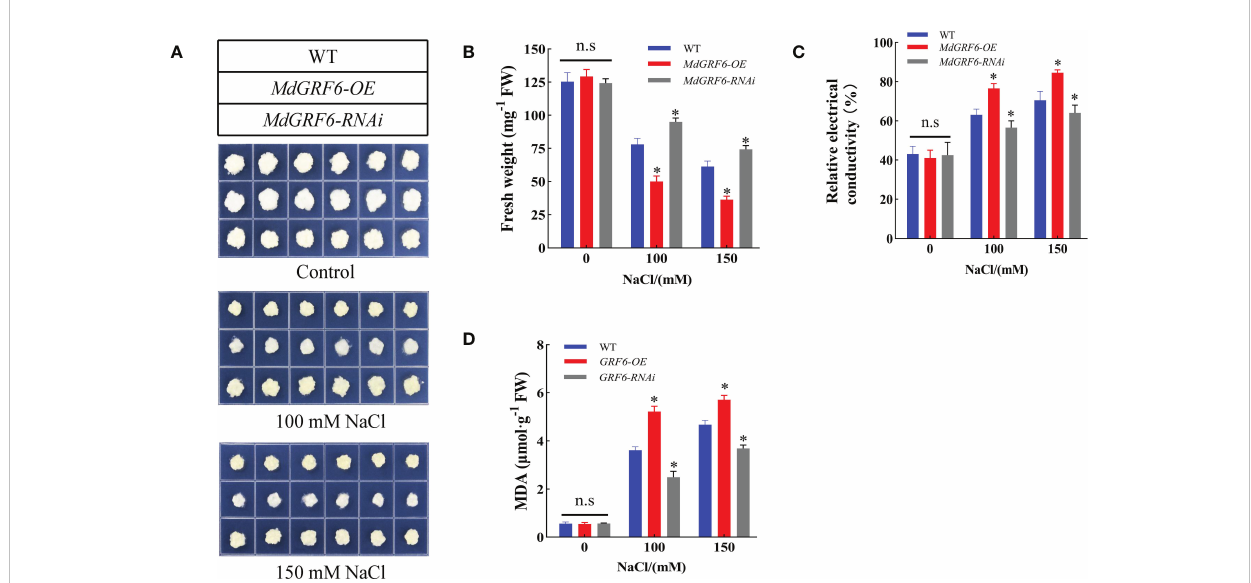
FIGURE 7 MdGRF6 enhanced sensitivity to salt stress in apple. (A) The phenotypes of transgenic and WT apple calli in response to NaCl treatment. The apple calli were placed on the MS medium containing 100 or 150 mM NaCl for 15 days. (B-D) Fresh weight, electrical conductivity, and MDA content of the WT and transgenic apple calli after 15 days under salt treatment. Error bars indicate the means ± SD (n = 3). The asterisks indicate signi fi cant differences (LSD test, * P < 0.05; ns, no signi fi cant